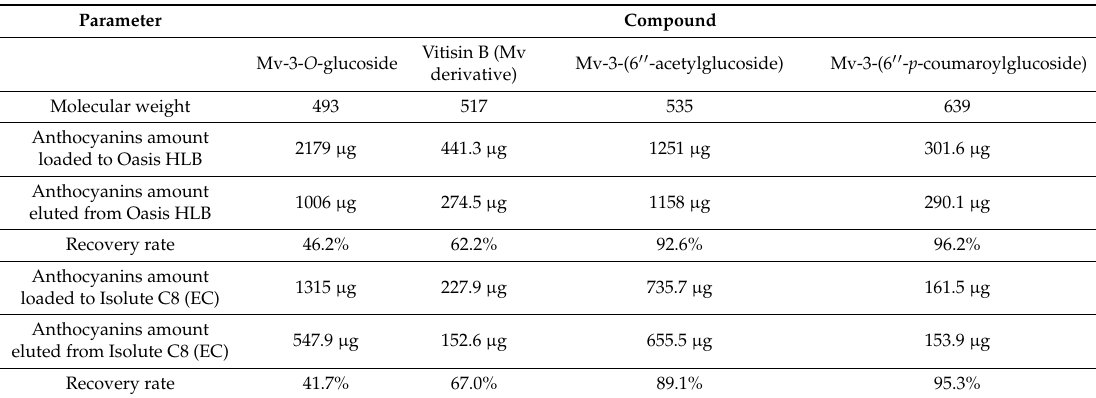
Table 7. Results after LC-PDA-MS